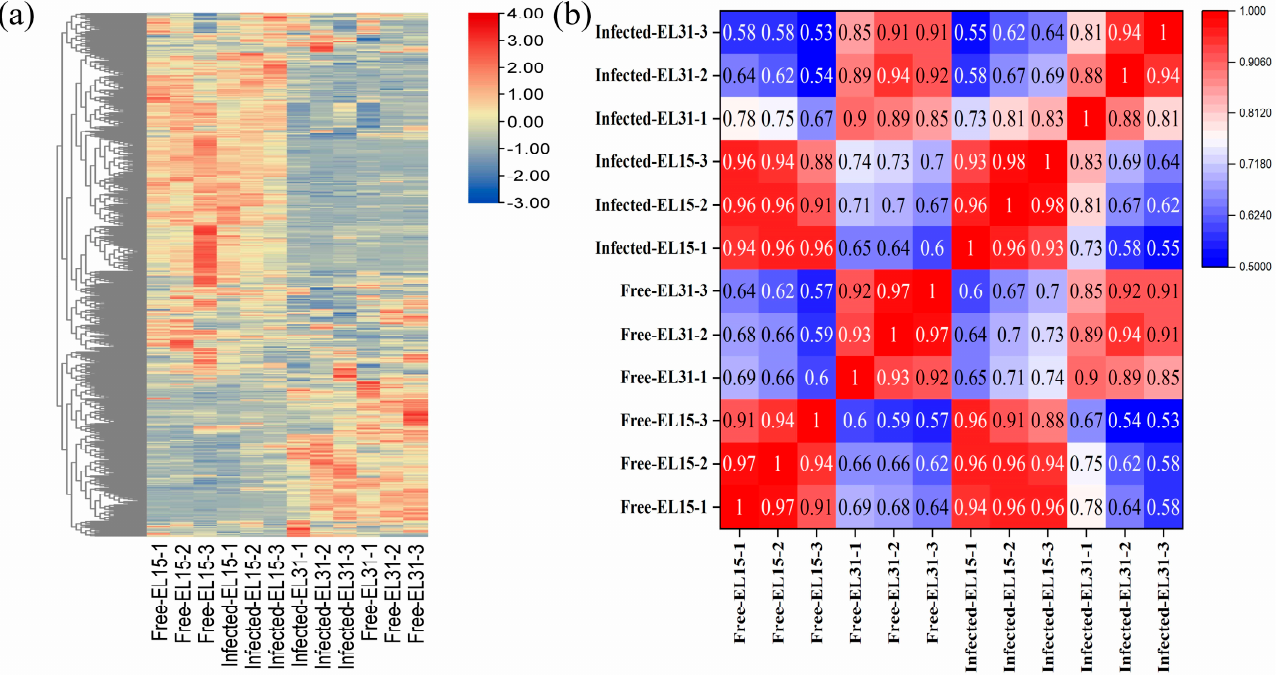
Figure 8. Analysis of differentially expressed metabolites (DEMs) in leaves. ( a ) Metabo- lites with significant increases or decreases in at least one of the comparisons. The four clusters(I–IV) represent the respective response patterns (Table S16). A small fraction of metabolites was selected from each cluster. ( b ) Top 20 enrichment pathways on the basis of KEGG analysis of the total DEMs between GFabV–infected and GFabV–free leaves at EL15; ( c ) KEGG annotation of top 20 DEMs at EL31. The size of bubble represents the number of metabolites in the pathway, the color represents the P value.